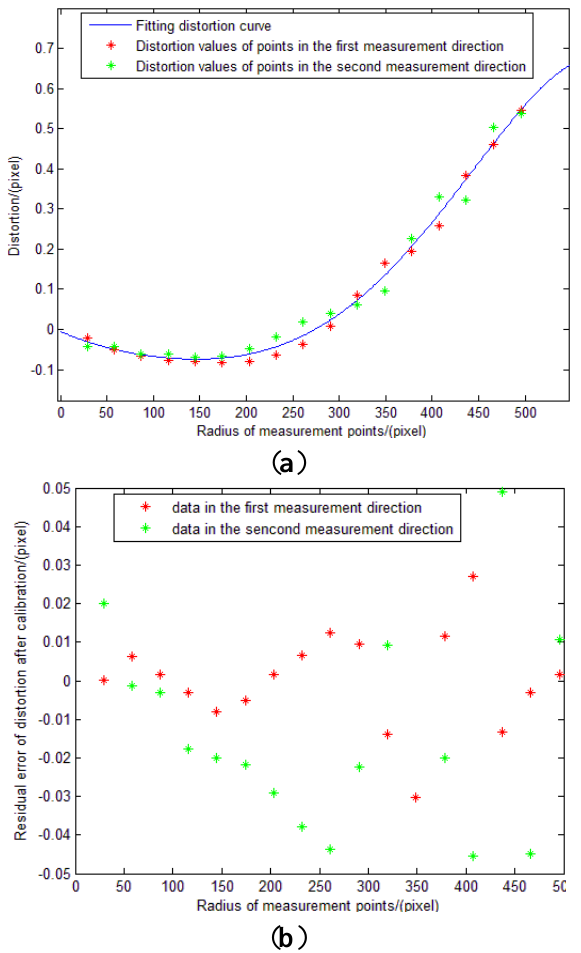
Figure 23. Distortion curve. ( a ) is fitting distortion curve and ( b ) is residual errors of distortion after